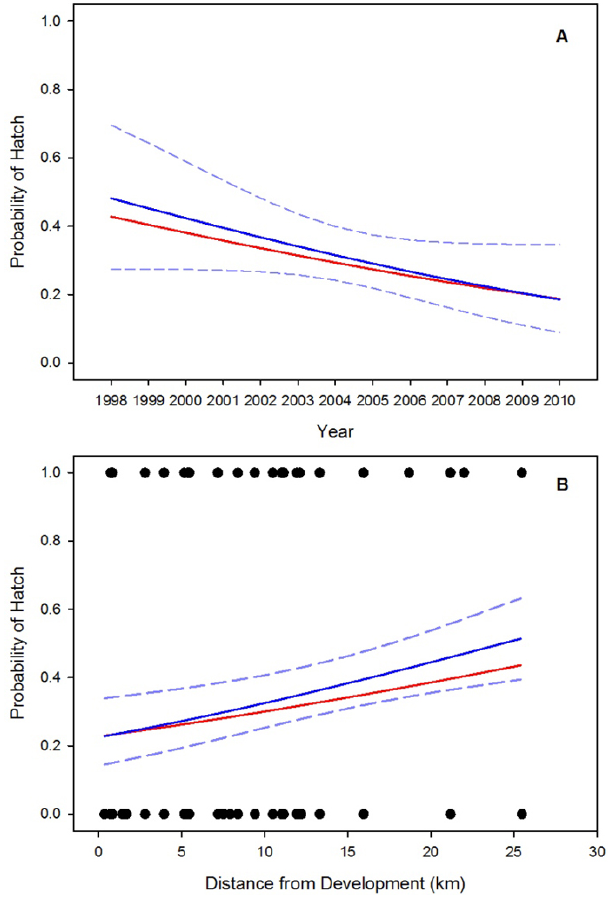
Fig. 3 . Probability predictions (± 95% CI; blue dash) of nest occupancy for Peregrine ( Falco peregrinus ) and Gyrfalcon ( Falco rusticolus ; blue line) in the Lac de Gras study area, during 2000 to 2010, based on the top ranked model (Table 2) for the effect of year of initial nest detection as an index of relative site age (A) and the maximum spatial extent of sensory disturbance (zone of influence; ZOI) estimated from exposure to two mines (B). Also shown are raw binomial observations (circles) by distance and the predictions for Peregrine Falcon (red line).